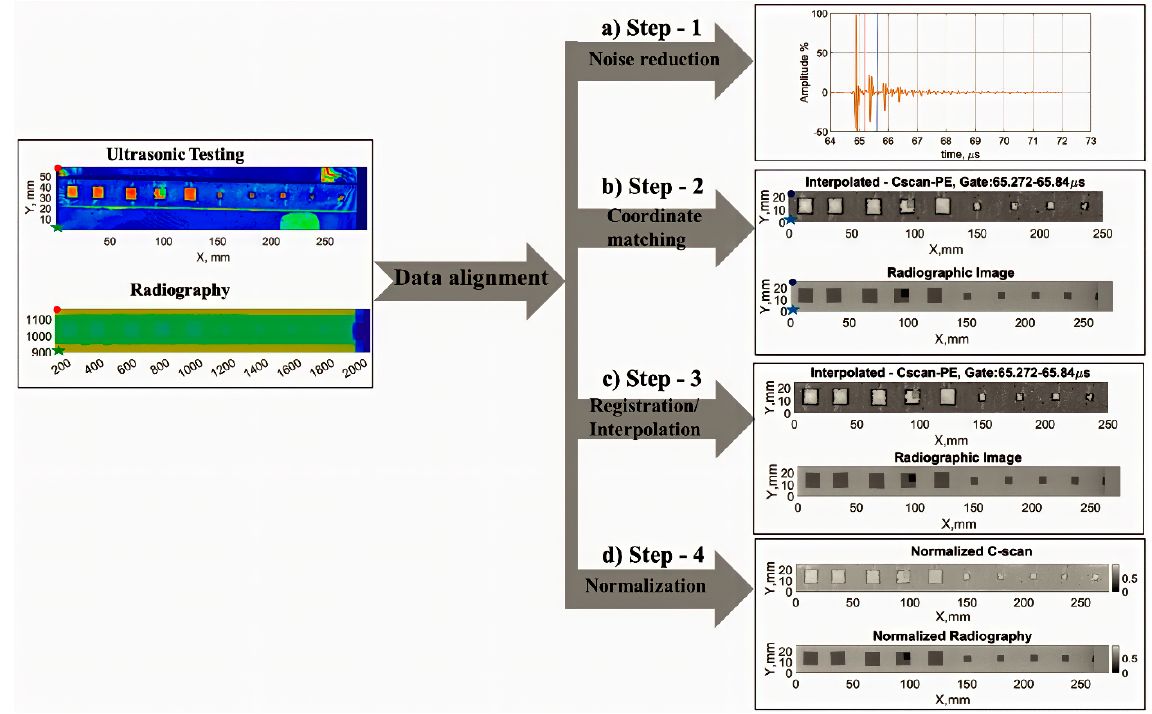
Figure 10. Measured data preparation for data fusion. Table 2. Different features extracted from the measured